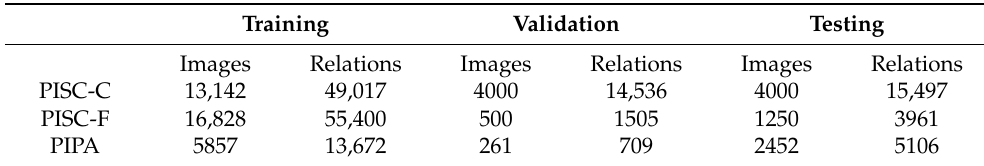
Table 2. The split details according to different social relation tasks. Training Validation Testing Images